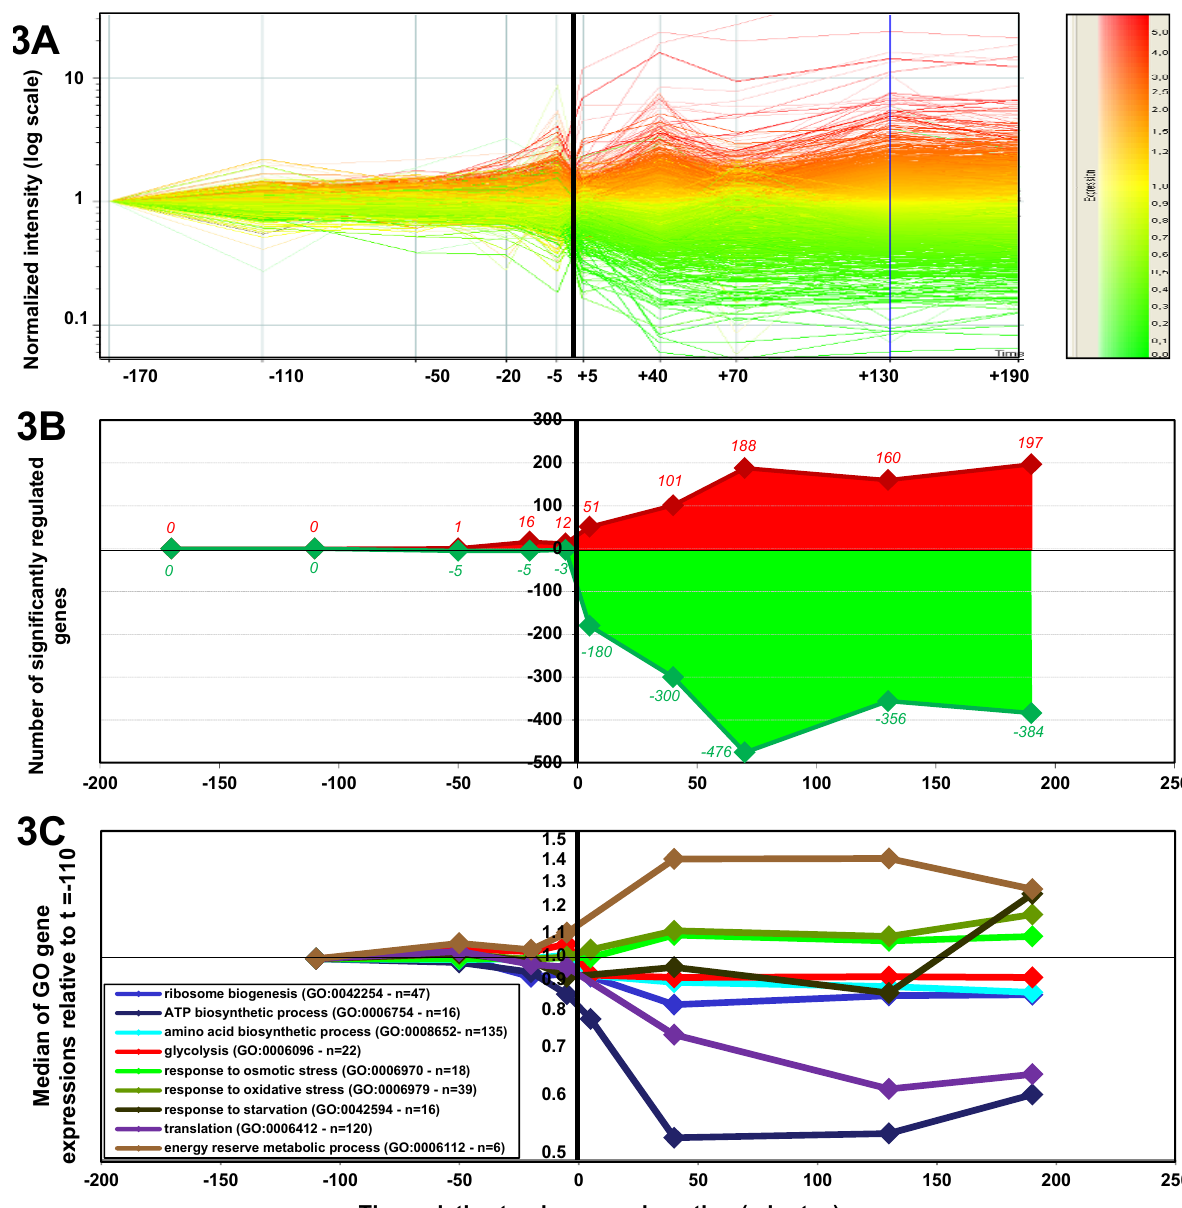
Figure 3. Changes in gene expression during the glucose/acetate transition. ( 3A ) The change in E. coli genome expression during the transition. Each line represents a change in the expression of a single gene, in comparison with the level of expression measured -170 min before GE. A color scale is used for the expression ratios (toward red when the gene is overexpressed; toward green when it is downregulated). ( 3B ) The number of significantly induced or repressed genes per time point ( t -test < 0.05; red: ratio over 1.5; green: ratio under 0.667). ( 3C ) The change in the median of gene expression for selected gene categories. The experiments were performed in three independent biological